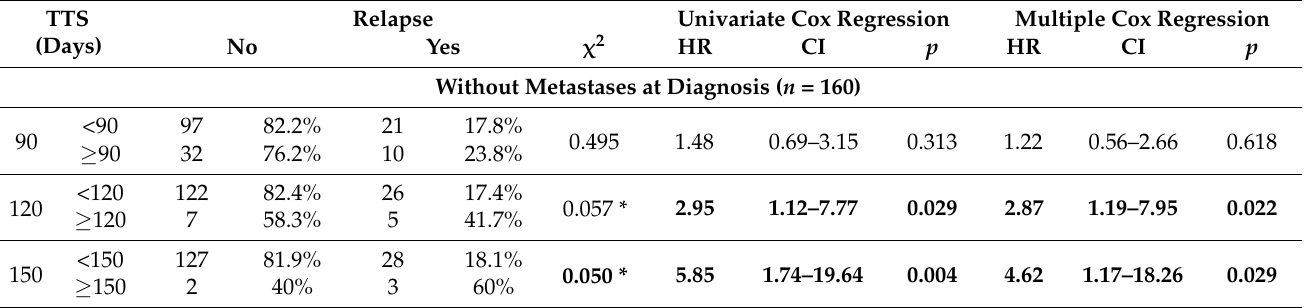
Table 2. Results of univariate und multivariate regression analysis of the impact of TTS on RFS at different time points for patients with bilateral WT with and without metastases at diagnosis. After 150 days of pretreatment, only 5 patients are included.